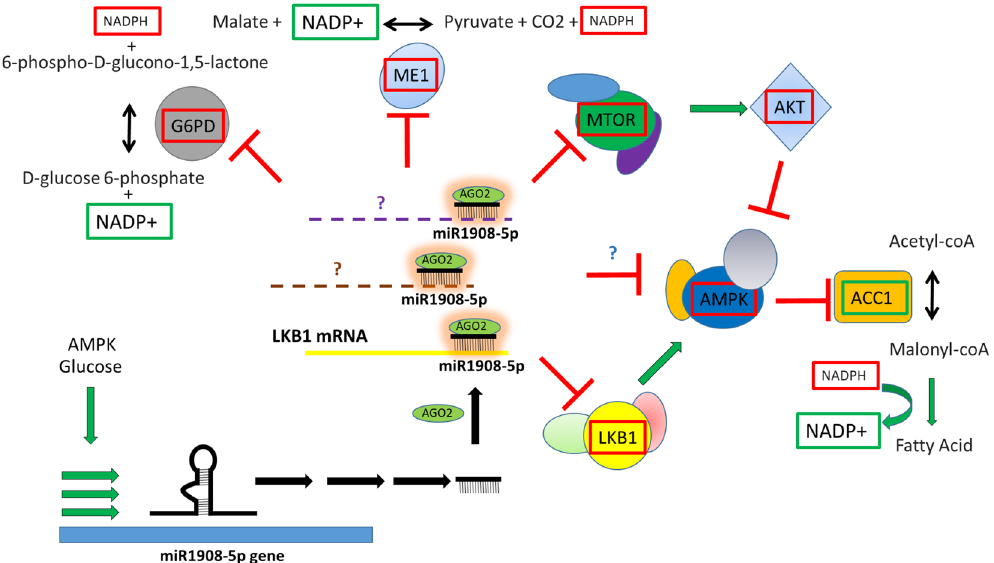
Figure 9. miR1908-5p interacts with cognate target mRNA to regulate the cellular energy landscape. miR1908-5p affects energy (NADP) homeostasis and sensing. miR1908-5p abundance is under the influence of glucose abundance and AMPK activity. In turn, miR1908-5p reduces LKB1 and AMPK levels and activity, in part via LKB1 transcript inhibition, while inhibiting mTOR and AKT. This is correlated with reduced ACC1 phosphorylation which is predicted to increase its activity and promote fatty acid synthesis. Increased fatty acid synthesis may however be counteracted by reduced NADPH availability due to lower G6PD and ME1 expression. Red and green highlights indicate reduced or increased activation and/or level, respectively as a result of miR1908-5p